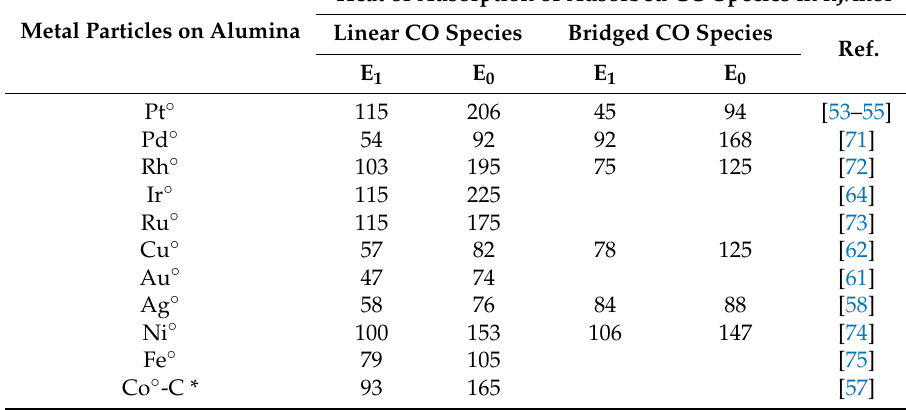
Table 1. Heats of adsorption at low (E 0 ) and high (E 1 ) coverages of the Linear and Bridged CO species adsorbed on different metal supported particles on metal oxides by using the AEIR method. Heat of Adsorption of Adsorbed CO Species in Metal Particles on Alumina